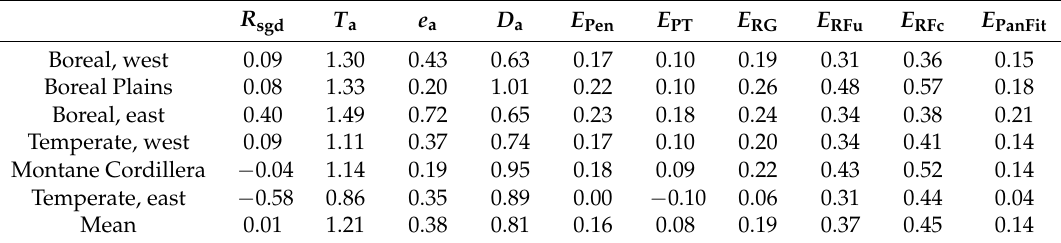
Table 4. Ecozone-average long-term changes in warm-season (May–September) mean daily variables over the period 1951–2014: Incident global solar radiation, R sgd (MJ · m − 2 · day − 1 ), air